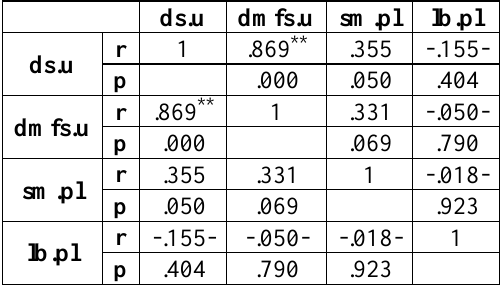
Table 7: Pearson correlation for upper primary teeth with streptococcus and lacto bacillus bacteria in plaque ds.u